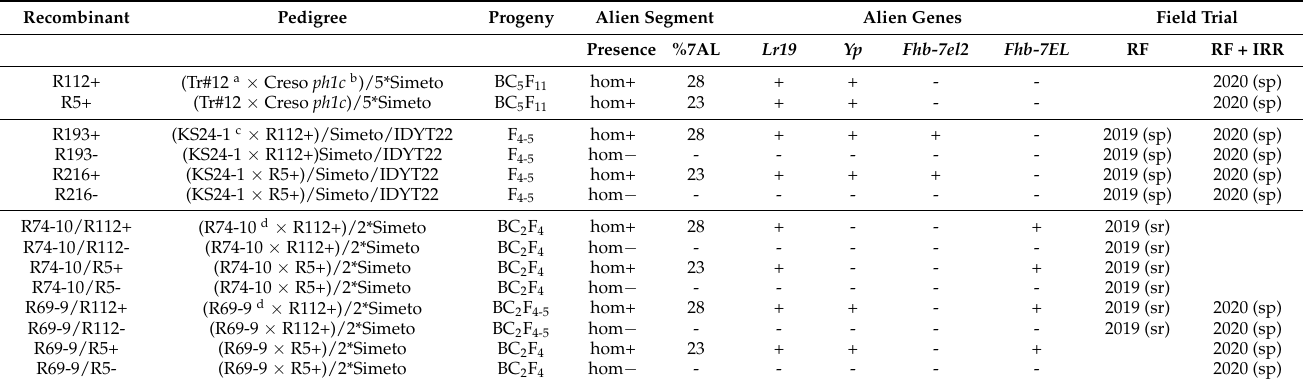
a Bread wheat translocation line with 7AL and 61% proximal 7AS arms replaced by Th. ponticum 7el b Mutant line of 1 chromatin [36]. durum wheat cv. Creso for the Ph1 gene on the 5BL arm that controls homoeologous pairing [44]. c Bread wheat translocation Fhb7el 2 donor line with the 7DL arm replaced by Th. ponticum 7el 2 chromatin [32]. d Bread wheat recombinant lines with 70% of 7DL arm replaced Figure 2. Field view of the R112+ derived nested recombinant lines in 2019 season. by an alien segment composed of Th. ponticum 7el 1 L and Th. elongatum 7EL chromatin [34]. Both lines harbour the Fhb7E